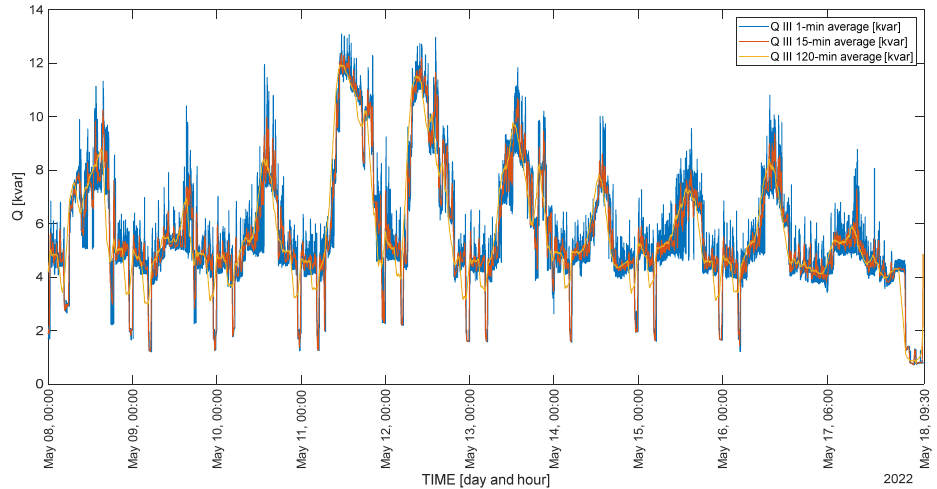
Figure 8. Three-phase reactive power as a function of time in the 3rd stage of the cycle. One representative day in each cycle’s stage was selected for detailed analysis. The graphs (Figures 3–8) show the changes caused by the total switching off of lighting to regulate the daily light cycle. Figure 9 shows the value of three-phase active power on a representative day of cycle stage 1 (11 April), Figure 10 shows the value of three-phase active power on a representative day of cycle stage 2 (18 April), Figure 11 shows the value of three-phase active power on a representative day of cycle stage 3 (15 May). Accord- ingly, Figures 12, 13, and 14 show the values of three-phase reactive power on the repre- sented days. Table 4 summarizes the most important parameters describing the electrical parameters of the representative days of each stage of the cycle. Figure 9. Three-phase active power as a function of time on a representative day of the 1st stage.